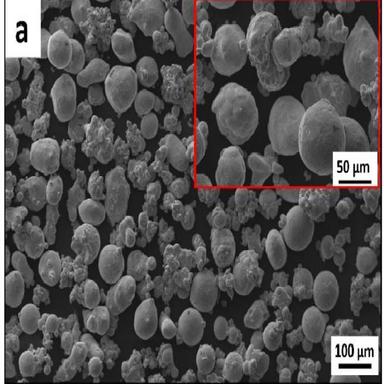
SEM image of the (a) as-received s-Cu powders and (b) f-Cu powders obtained by milling of s-Cu powders for 2h.